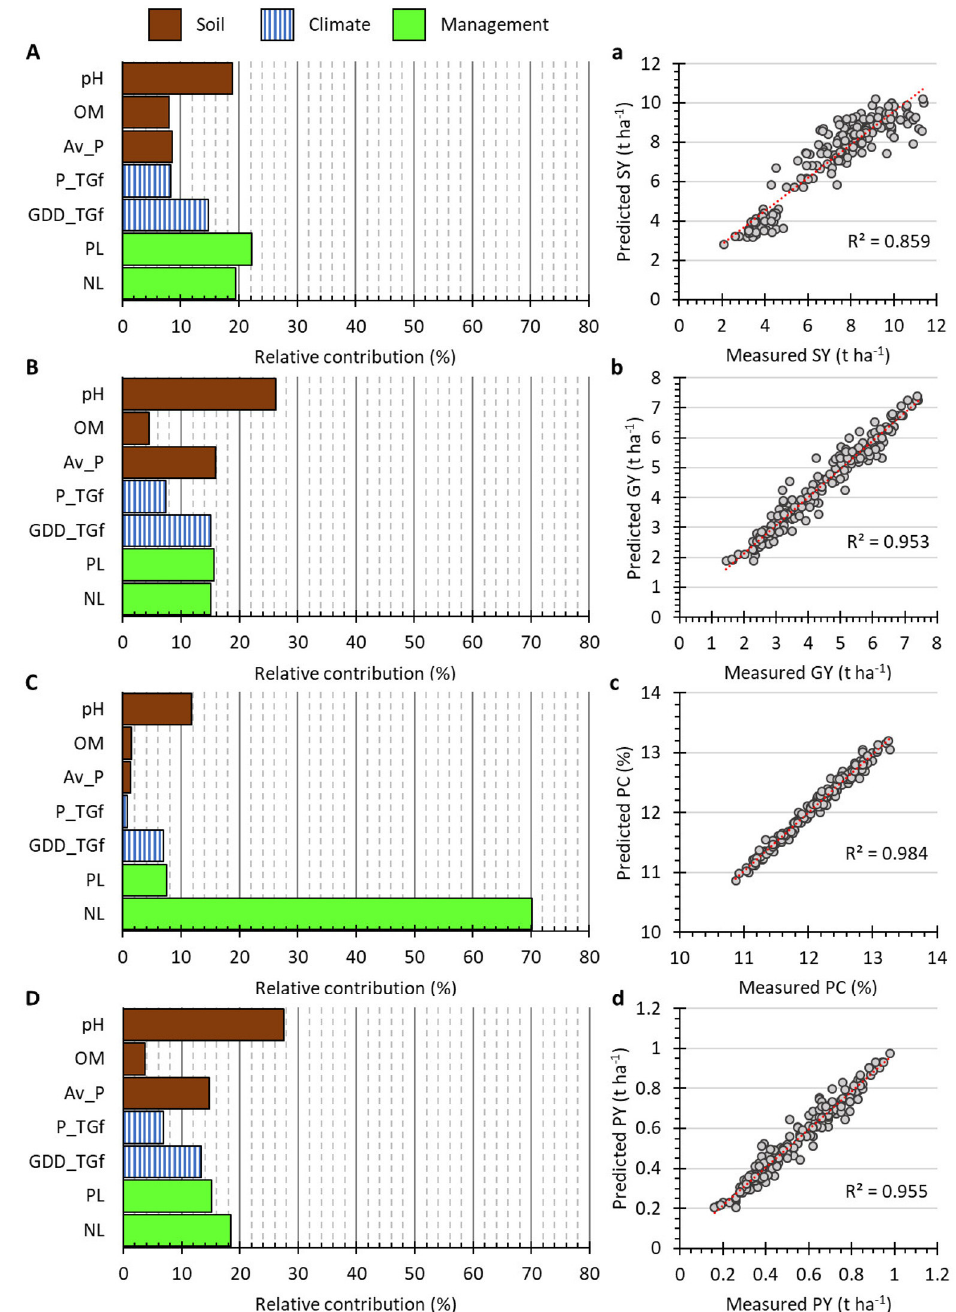
Figure 5. The relative contribution (%) of predictor parameters for the boosted regression tree model (BRTM) of straw yield (SY), grain yield (GY), protein concentration (PC), and protein yield (PY) shown in ( A – D ), respectively. Measured and predicted annual SY, GY, PC, and PY by the BRTM model using predictors shown in ( a – d ), respectively.